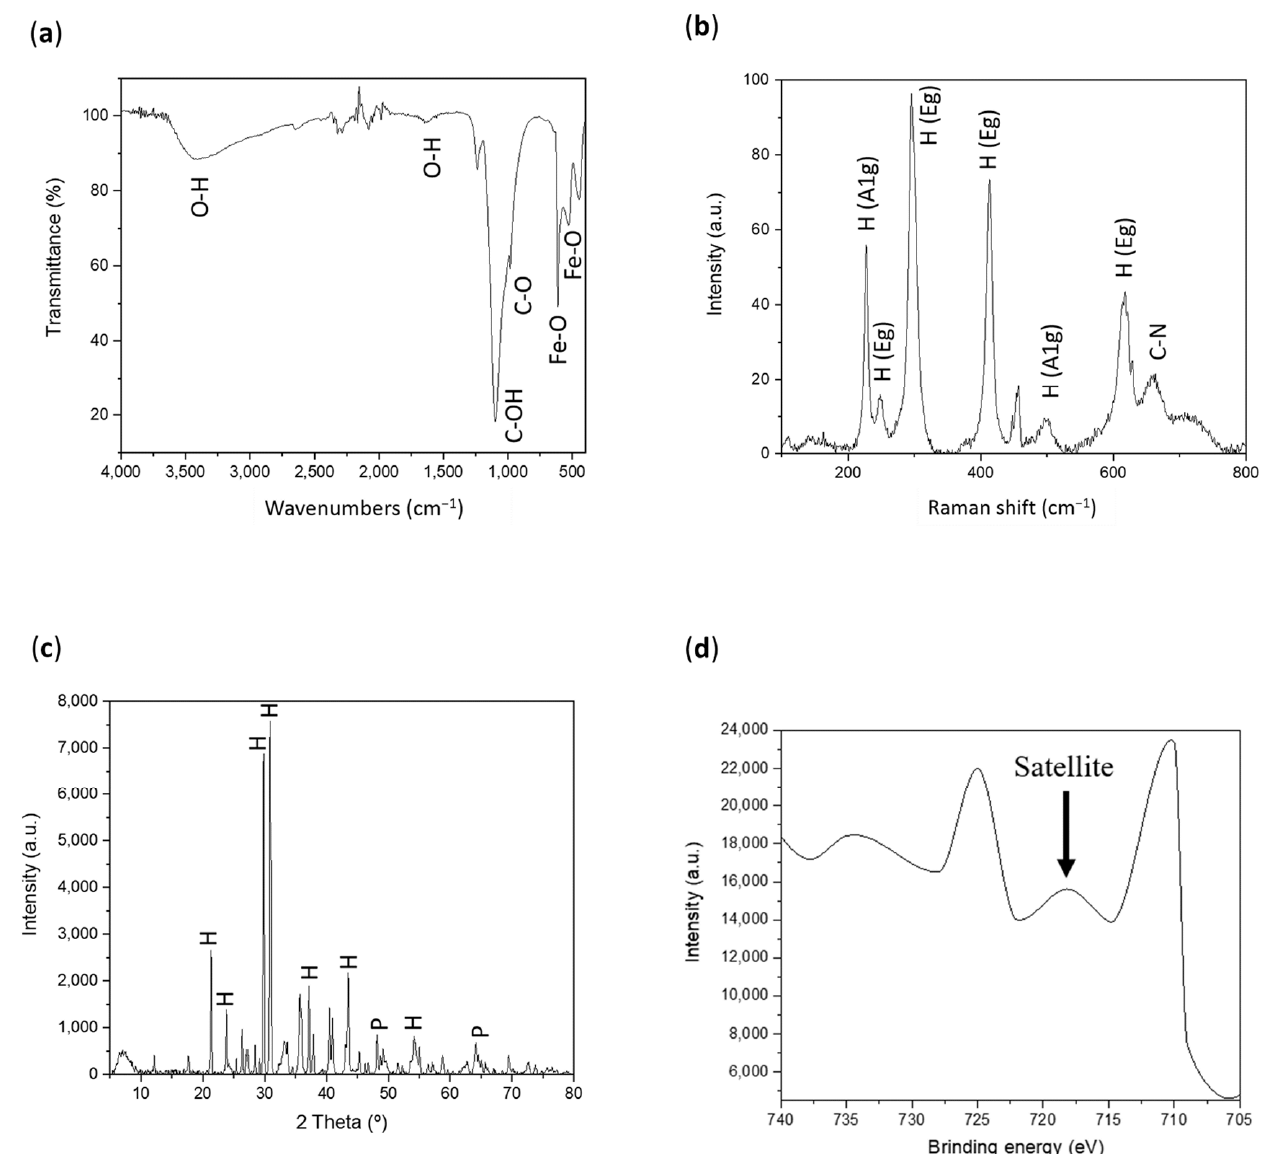
Figure 1. Fe-DES characterisation: ( a ) FTIR; ( b ) RAMAN, where H: hematite; ( c ) XRD, where H: hematite and P: propionamide; ( d )